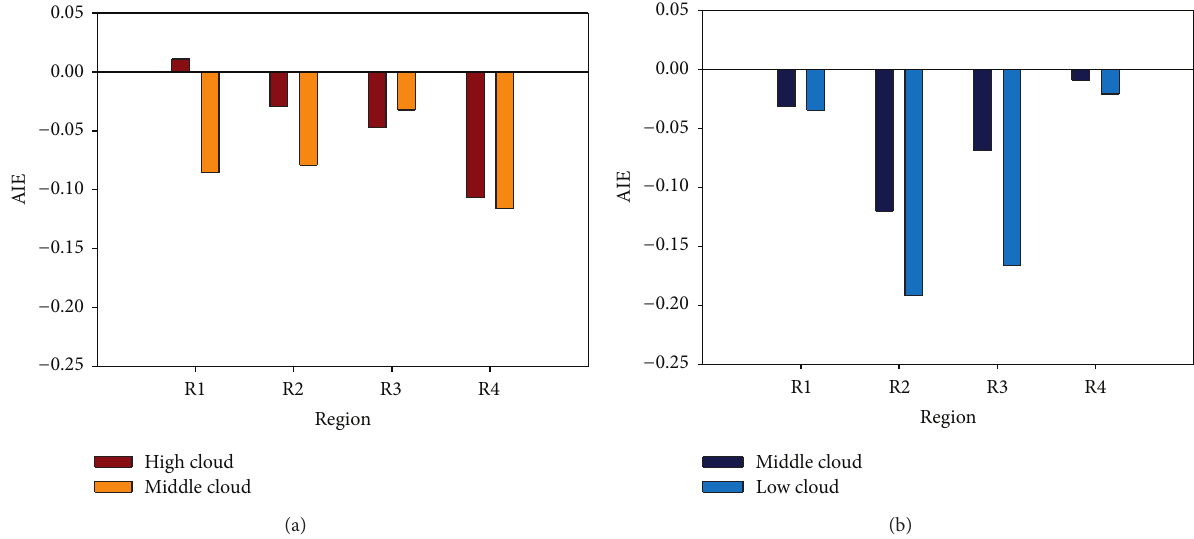
Figure 6: Regional climatological mean aerosol indirect effect during Changma period for (a) ice in high (red) and middle cloud (orange) and (b) water particle in middle (blue) and low cloud (sky